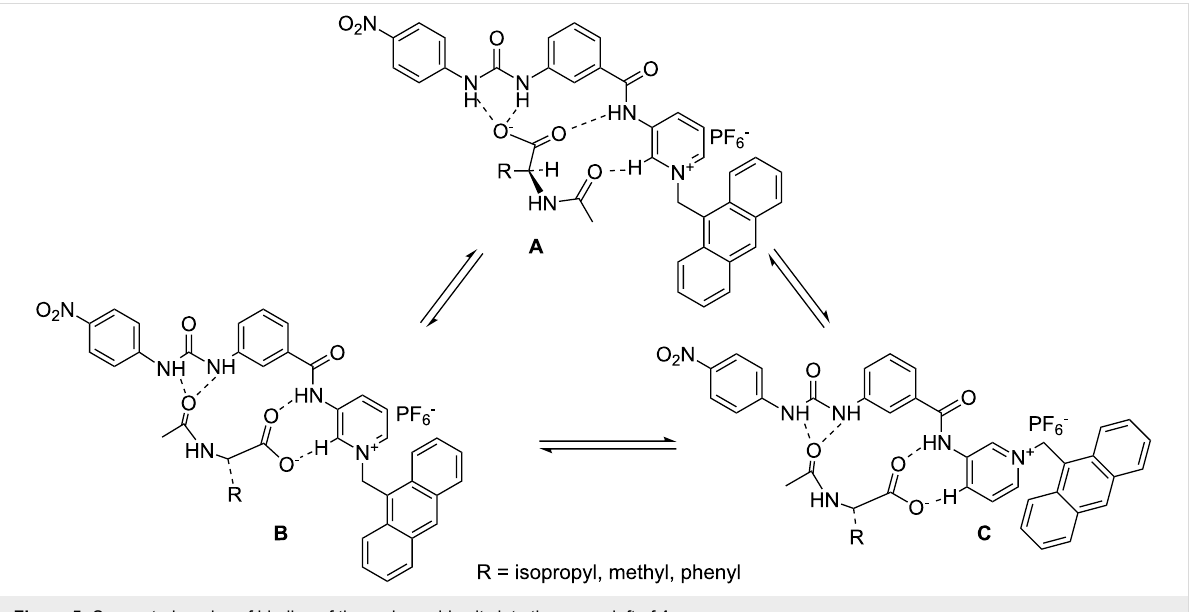
band at 492 nm was observed when the titration was carried out by gradual addition of the valine salt (Supporting Information File 1). This was also the case for the alanine salt. The other salts merely perturbed the emission of 2 and thus indicate the positive role of the urea motif in 1 for effective complexation of anionic substrates. This is in accordance with Hamilton’s obser- vation